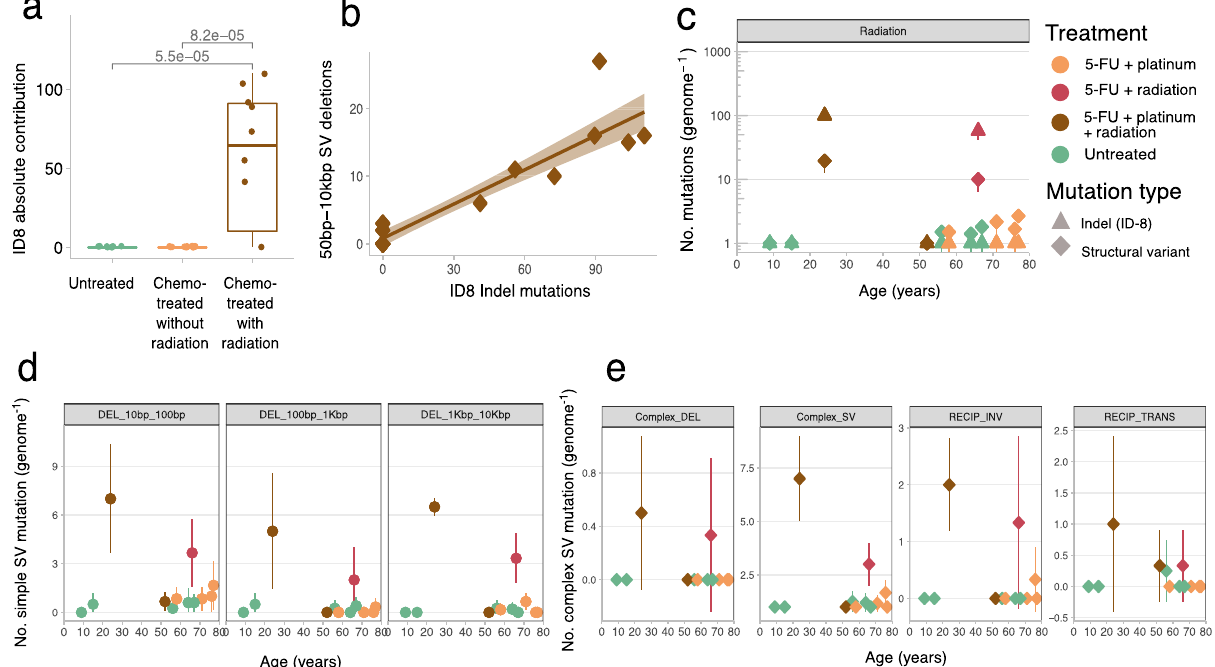
Fig. 4 | Radiotherapy-induced mutations in healthy colorectal ASCs. a Box and whisker plot indicating the absolute mutation contribution of COSMIC ID-8 indel signature between chemo-treated ASCs with ( n =10) and without ( n =18) radio- therapyanduntreated( n =19)colorectalASCs.Theboxintheboxplotdelimitsthe fi rstandthirdquartilesofthedistribution(withalinerepresentingthemedian);the whiskers delimit the lowest data point above the fi rst quartile minus 1.5 times the interquartile distance and the highest data point below the third quartile plus 1.5 times the interquartile distance. A Wilcoxon rank-sum test between every cohort was performed and the p value is illustrated at the top of the plot. b Scatterplot showing the relation between platinum ID-8 mutations ( x axis) and structural deletion variants ( y axis). The brown line displays the least-squares linear fi t while the shaded region represents the 95% con fi dence interval of the fi t (Pearson ’ s r =0.92). c Radiotherapy-induced indel and structural variant mutation